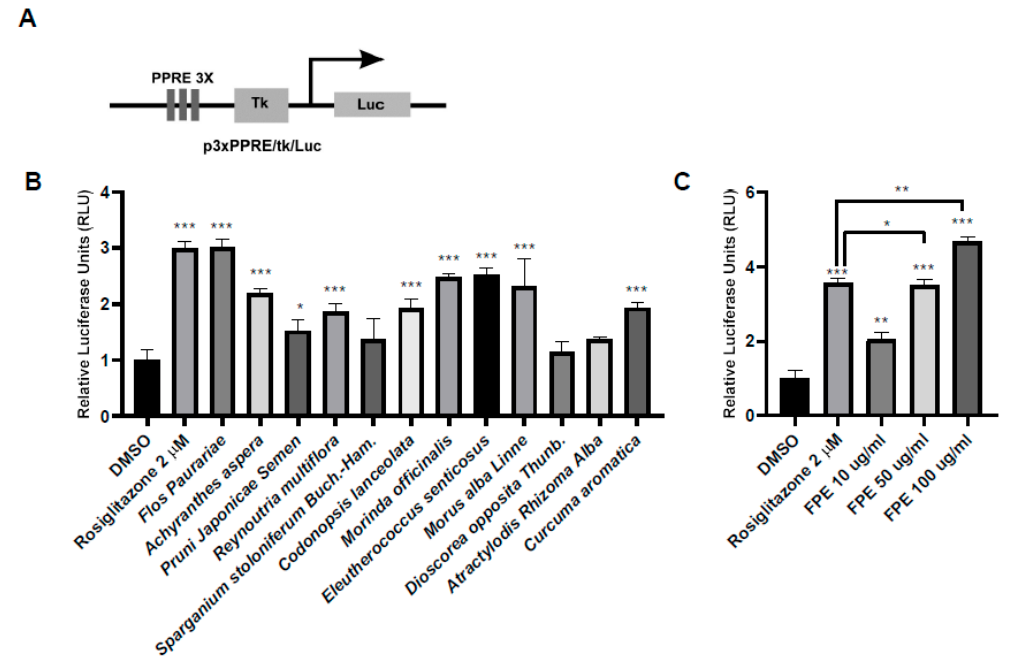
Figure 1. FPE induces PPAR γ activity, as assessed by dual-luciferase assay. ( A ) Structural elements of the PPAR γ luciferase reporter vector. ( B ) Screening of PPAR γ activity in transiently transfected with pcDNA3/PPAR γ , p3xPPRE/tk/Luc, and pRL plasmids into HCT116 cells and subsequently treated with 50 μ g/mL plant extracts for 24 h. The dual-luciferase assay was performed. The relative values are presented as mean ± SEM; n = 3, * p < 0.05, ** p < 0.001, *** p < 0.0001. ( C ) Ability of FPE to induce PPRE-luc expression, PPAR γ ligand-dependence, showed as dose-dependent manner. HCT116 cells were transiently transfected with pcDNA3/PPAR γ , p3xPPRE/tk/Luc, and PRL null plasmids were treated with 10, 50, and 100 μ g/mL FPE. Cells treated with 2 μ M rosiglitazone were considered as a positive control. Dual-luciferase assay was performed 24 h after treatment of cells with the plant extracts. Results were statistically analyzed using Dunnett’s multiple comparison test; n = 3, * p < 0.05, ** p < 0.01, *** p < 0.0001.